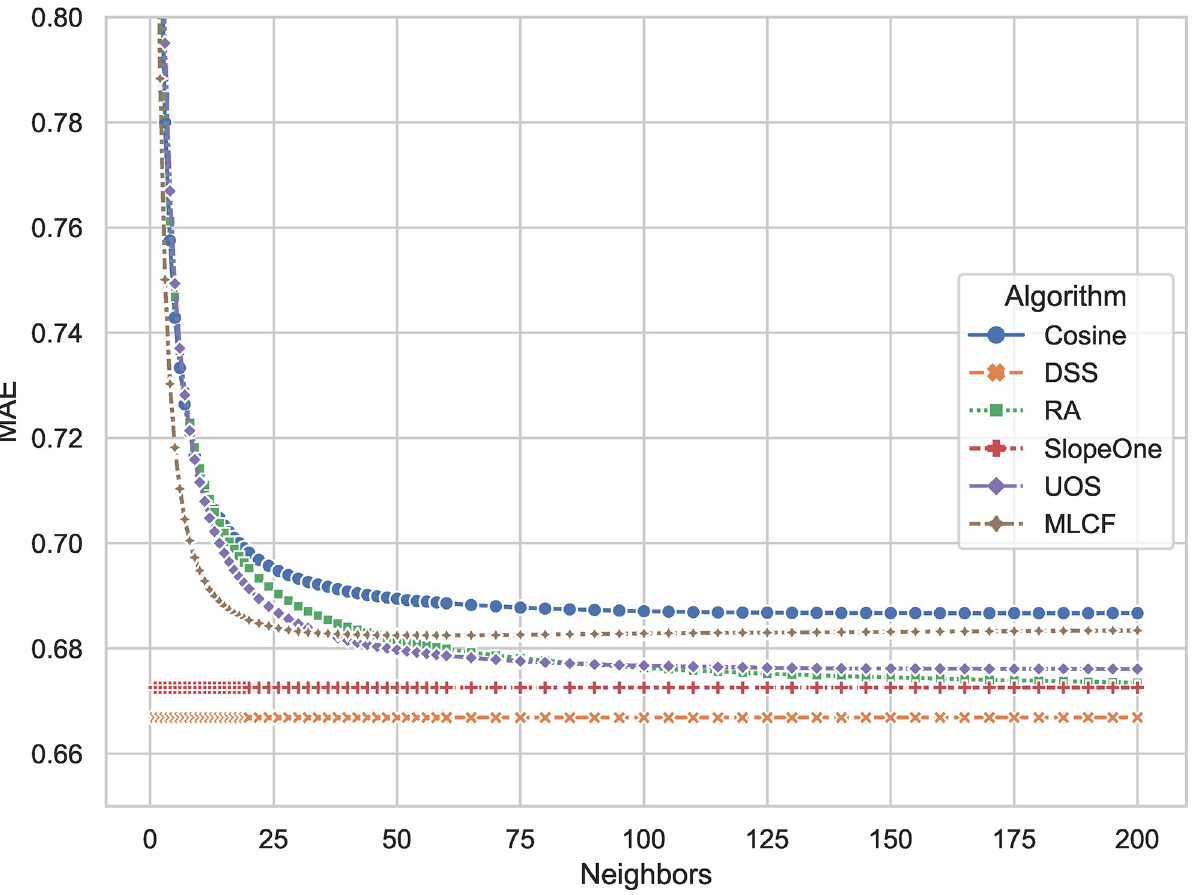
Fig 3. MAE comparison results of DSS and other algorithms. The smaller the result, the smaller the prediction error of the algorithms on the rating.